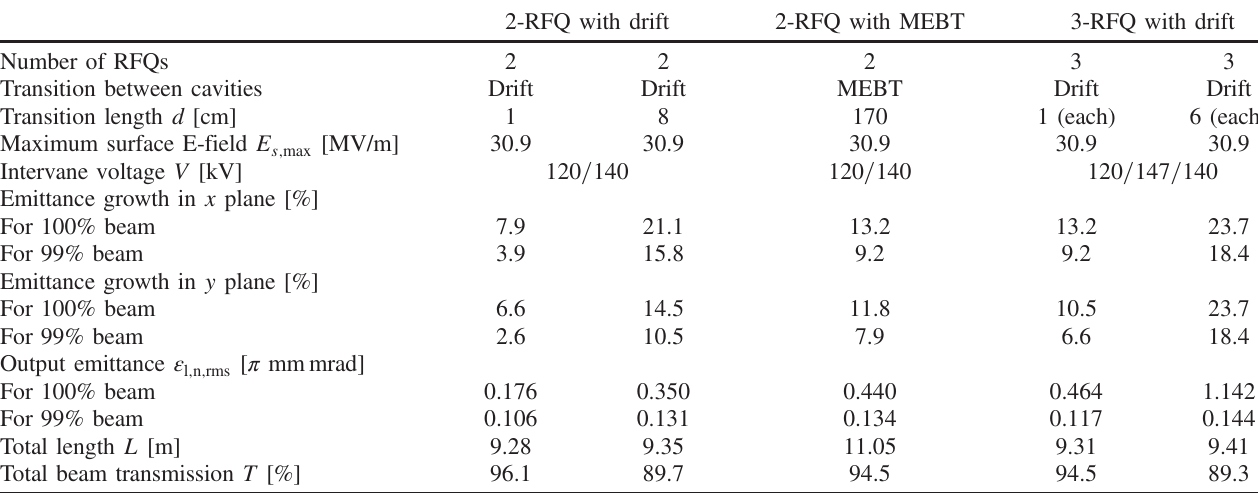
TABLE III. A comparison of the 2-RFQ and 3-RFQ solutions (input emittance ¼ 0 . 076 π mm